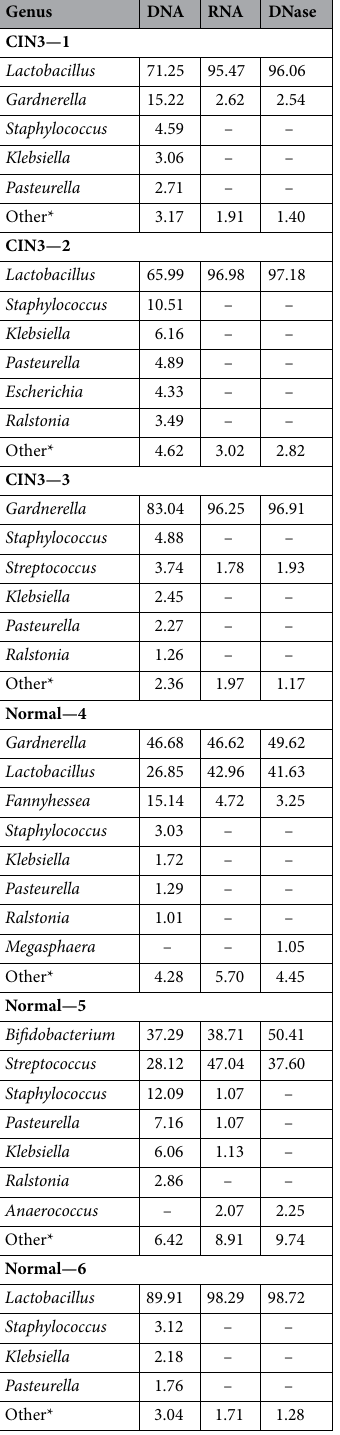
Table 2. The relative abundance of the annotated bacterial reads for each bacterial genus in percentage of the total number of bacterial reads detected in the 6 cervical swab samples by each sequencing approach (DNA sequencing, RNA sequencing and RNA sequencing with prior DNase-treatment). DNA = DNA sequencing, RNA = RNA sequencing, DNase = RNA sequencing with prior DNase-treatment. CIN3 = cervical intraepithelial neoplasia stage 3, Normal = healthy without neoplasia. *Other comprises bacterial genera that presented < 1% of total bacterial reads. The genera are sorted from the highest to lowest percentage of the total bacterial reads by DNA